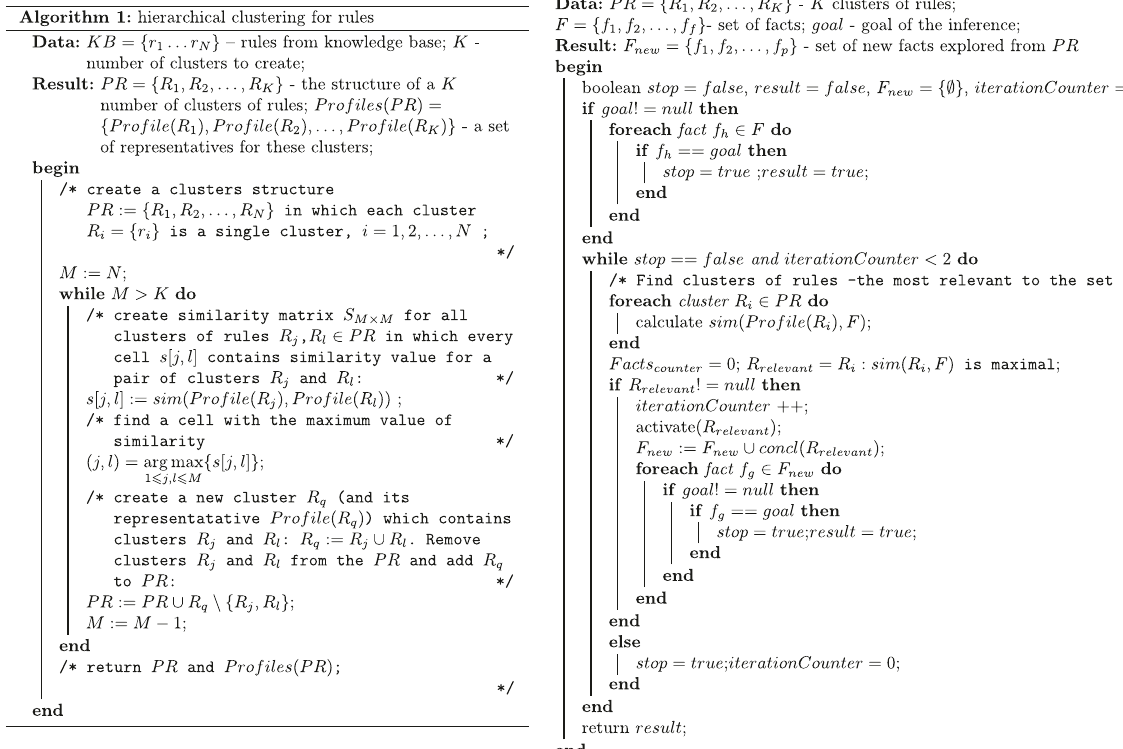
Figure 1: The pseudocodes of the hierarchical clustering algorithm for rules and the data-driven algorithm for rule